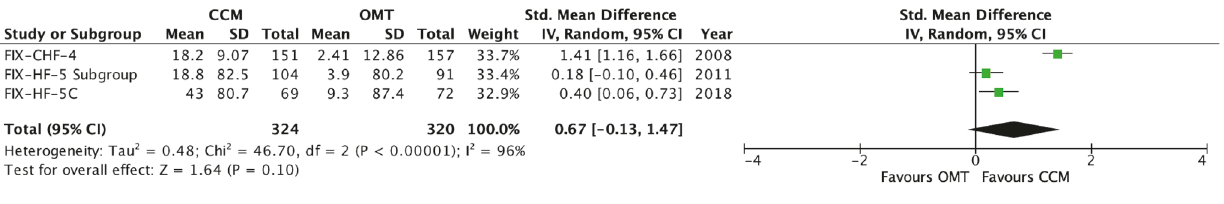
Figure 7: Forest plot of the six-minute walking distance in the CCM groups versus the control groups. A forest plot of the data available to us from the 4 RCTs assessing 6MWD in those with CCM compared to those with OMT alone. There was no statistically significant difference in 6MWD between these two groups.